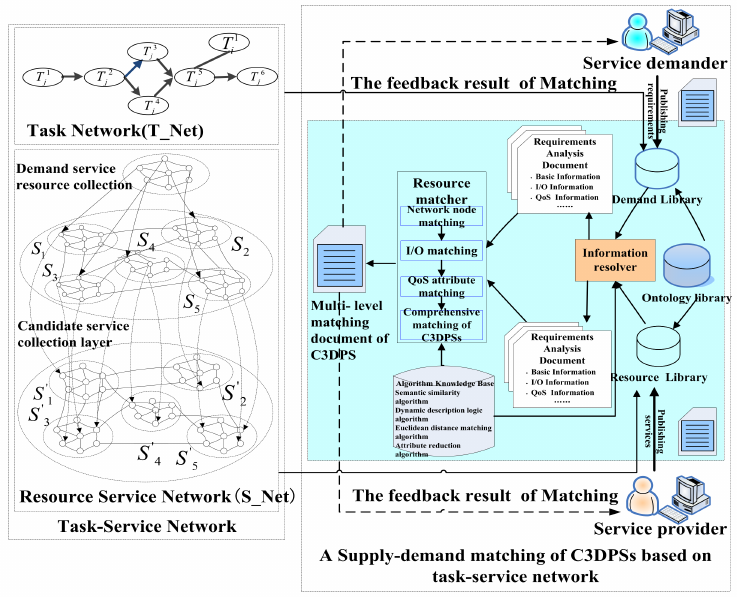
Figure 1. The framework of C3DPS Supply-demand matching is based on task-service network